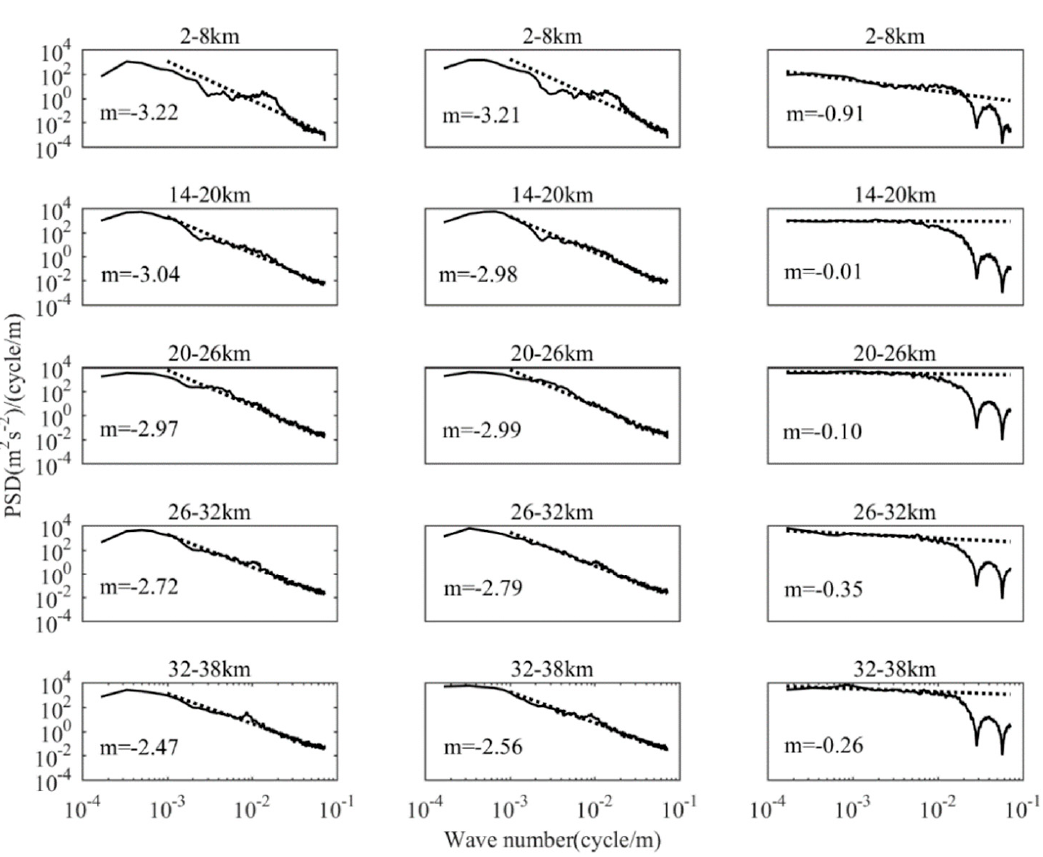
Figure 6. Average vertical wavenumber spectrum of zonal wind (left panel), meridional wind (middle panel), vertical wind (right panel), the dashed line represents the linear fitting result, and the corresponding slope m is marked on the figure. Table 2. Spectrum slope and amplitude of normalized temperature